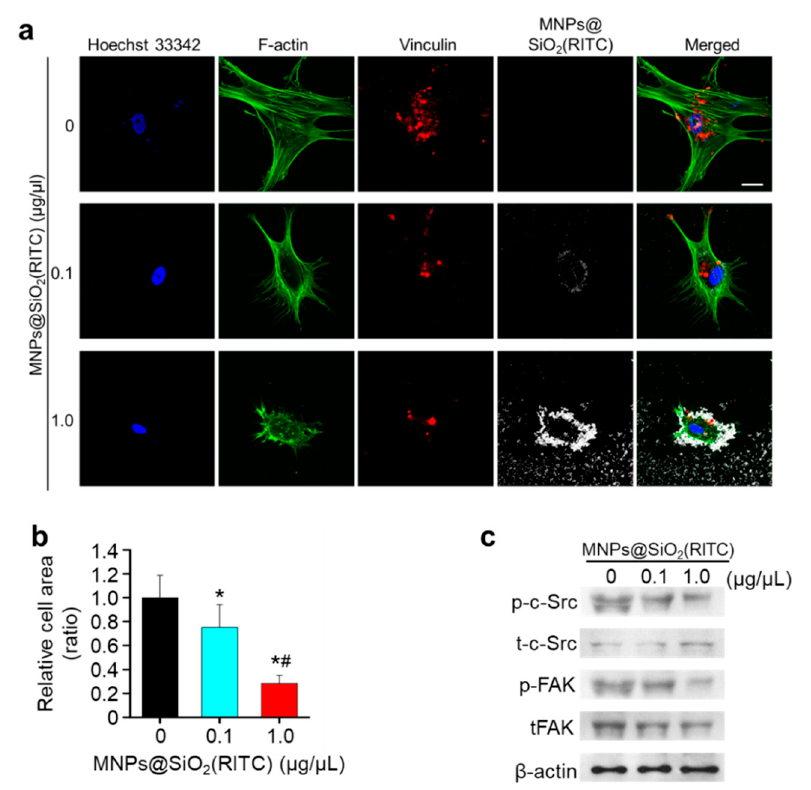
Figure 4. Shrinkage and abnormal focal adhesion of hBM-MSCs treated with MNPs@SiO 2 (RITC). ( a ) Images of F-actin based cytoskeleton and focal adhesion in MNPs@SiO 2 (RITC)-treated HEK293 cells. Green, F-actin; red, vinculin; white, MNPs@SiO 2 (RITC); blue, Hoechst 33342. Scale bar = 20 µ m. ( b ) Relative attached area of MNPs@SiO 2 (RITC)-treated hBM-MSCs compared to non-treated control. Data represent mean ± SD ( n > 30). * p < 0.05 vs. non-treated control. # p < 0.05 for the comparison between 0.1 and 1.0 µ g / µ L MNPs@SiO 2 (RITC)-treated cells. ( c ) Immunoblotting analysis associated with focal adhesion. p-, phosphorylated protein; t, total protein. β -Actin was used as an internal